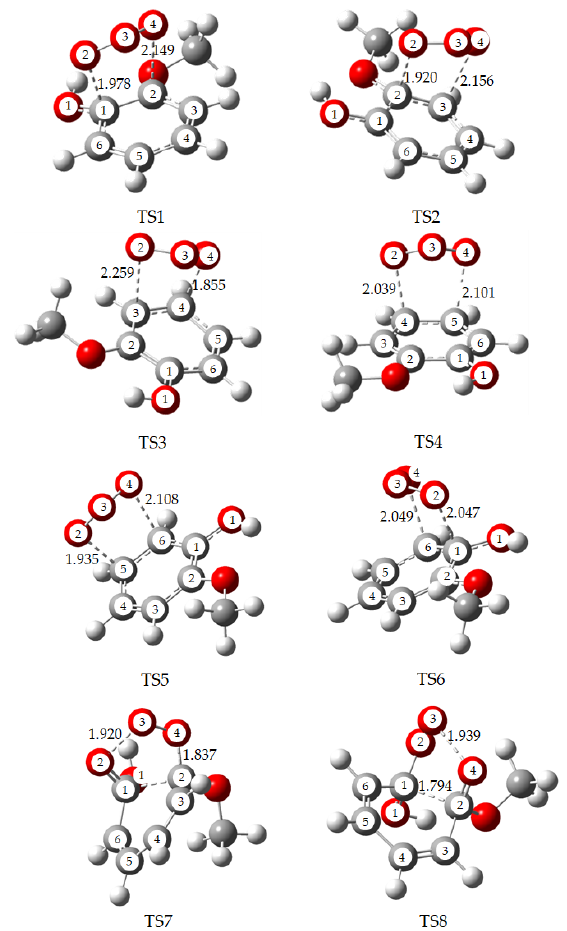
Figure 3. MPWB1K / 6-31 + g(d,p) optimized geometries for the transition states involved in the initial Figure 3. MPWB1K/6-31+g(d,p) optimized geometries for the transition states involved in the initial reaction of guaiacol + ozone with main bond lengths. Bond lengths are in Å. reaction of guaiacol + ozone with main bond lengths. Bond lengths are in Å. Int. J. Mol. Sci. 2019 , 20 , x Criegee intermediates are labile and can react with H 2 O, NO x in the atmosphere to take place subsequent reactions, or undergo self-decomposition or isomerization. In the following section, IM8 is chosen as representative to explore their secondary reactions. The reaction mechanisms of the other Criegee intermediates (IM7, IM9-IM18) are similar to IM8. Figure 4 exhibits the potential energy surfaces of all the POZs and Criegee intermediates, emerging the degree of difficulty at each reaction pathway in a more intuitive manner.